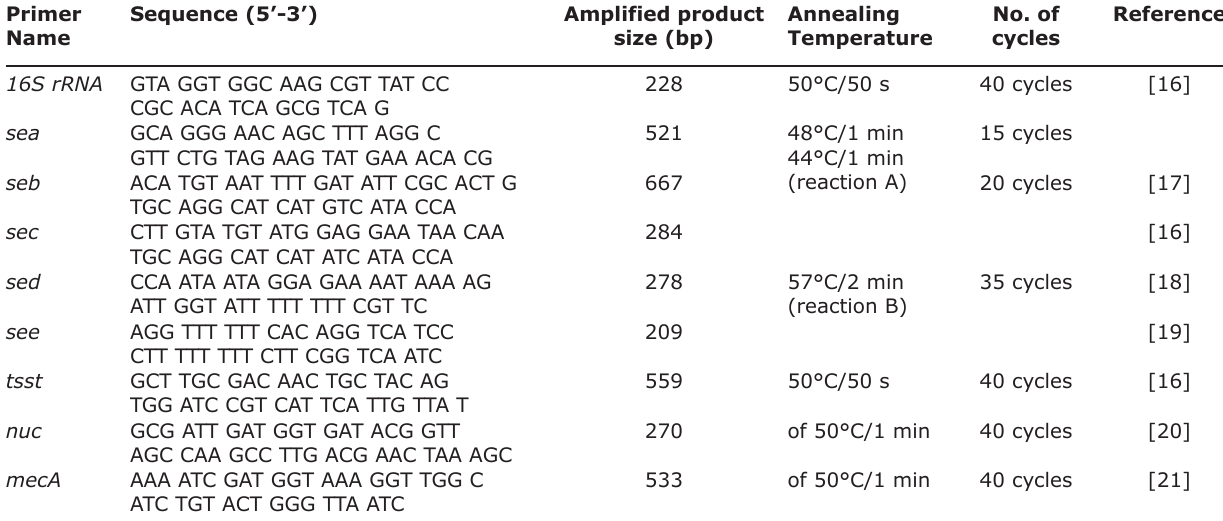
Table-1: Primer sets used to amplify fragments of 16S rRNA , enterotoxins, and virulence factors genes in S. aureus. Primer Name